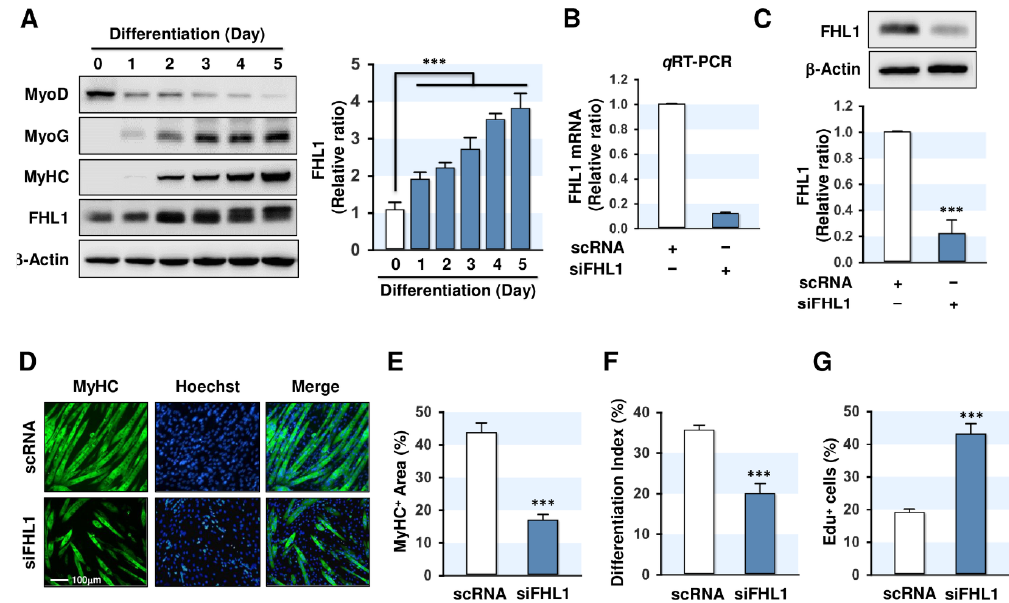
Figure 2. Knockdown of FHL1 impairs myogenic di ff erentiation. ( A ) C2C12 myoblasts were di ff erentiated up to five days, and the expression of FHL1 was analyzed. Expression of FHL1 in immunoblots was normalized with β -Actin. The values are expressed as the relative ratio, where the intensity of day 0 was set to one. ( B ) q RT-PCR analysis of FHL1 expression after 24 h of transfection with 100 nM of scRNA control or FHL1 siRNA (siFHL1). GAPDH was used as a control. ( C ) Immunoblot analysis of FHL1 after 24 h of transfection. ( D ) C2C12 myoblasts were transfected with 100 nM of scRNA control or siFHL1 and were di ff erentiated for five days. Immunofluorescence staining with a specific antibody against MyHC (green). Hoechst (blue) was used to stain nuclei. Scale bar: 100 µ m. ( E – G ) MyHC-positive area, di ff erentiation index, and Edu-positive cells were determined as described in Materials and Methods. Results are expressed as means ± SEMs ( n > 3). ***, p <